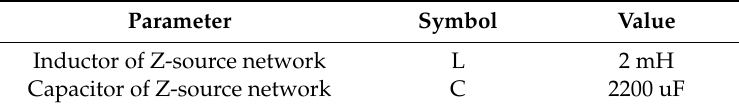
Table 1. Parameters of the Z-source network.